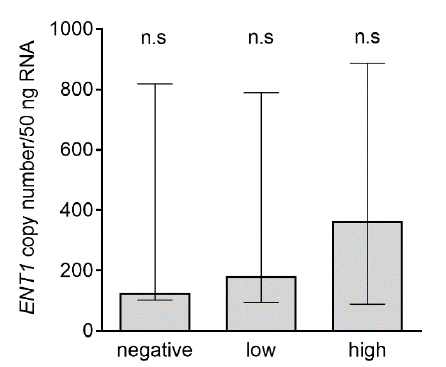
Figure 5. Analysis of ENT1 transcripts in subgroups with negative, low, and high ENT1 protein expression. Patients were divided based on histoscore of ENT1 expression (and denoted negative ( n = 9), low ( n = 30) or high ( n = 24)); see Methods section. Data are presented as median with interquartile range. Di ff erences in the number of transcripts among subpopulations were analyzed using the nonparametric Kruskal–Wallis test, followed by Dunn’s multiple comparison; n.s., not